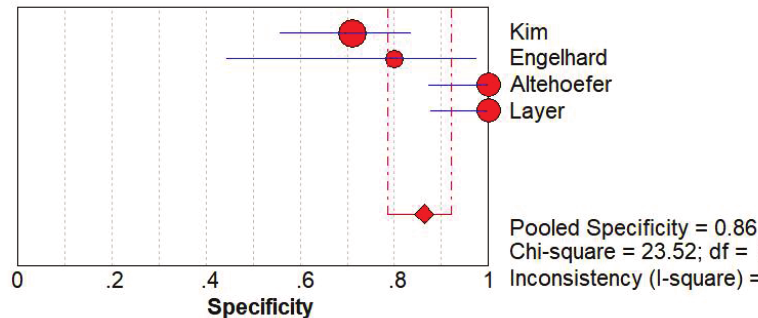
Figure 5: The plot for the specificity of BS